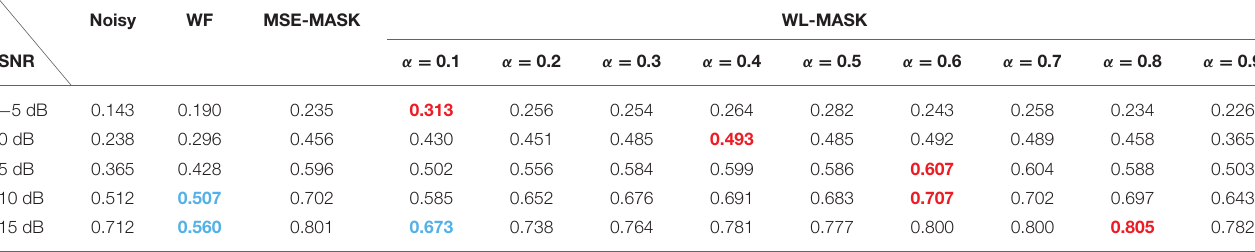
TABLE 1 | The mean ECM score results for different systems under SSN. Noisy WF MSE-MASK WL-MASK SNR α = 0.1